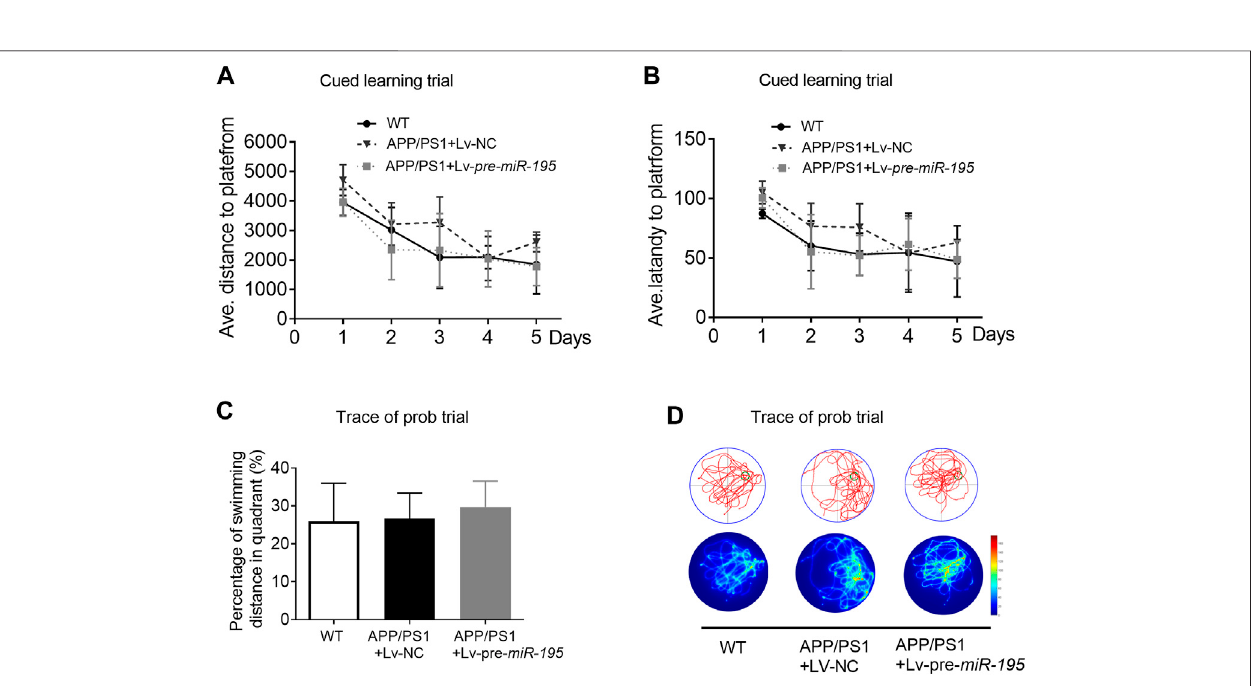
Frontiers in Pharmacology |